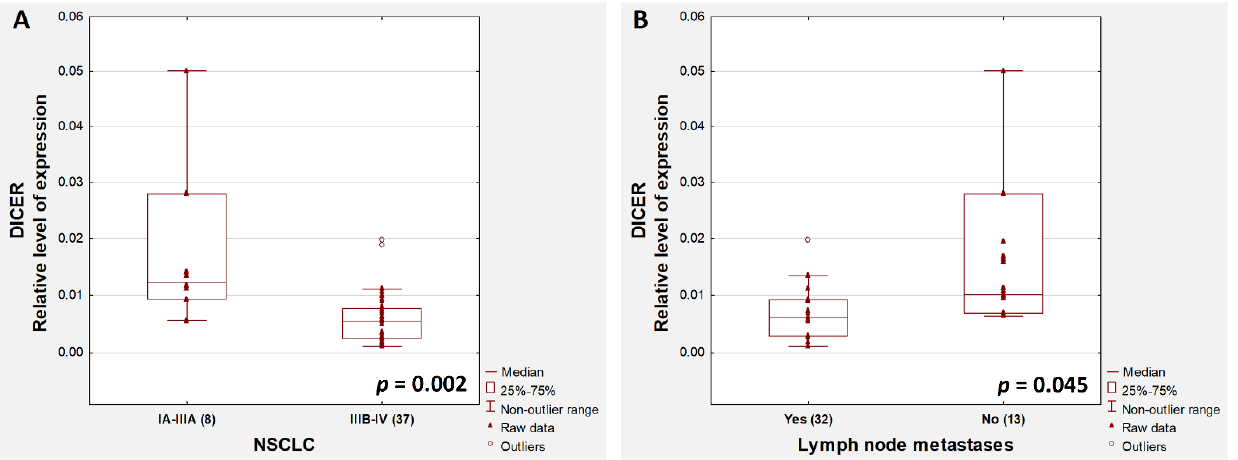
Figure 4. Comparison of expression of DICER according to NSCLC stage ( A ) and occurrence of lymph node metastases ( B ) (description it the text).